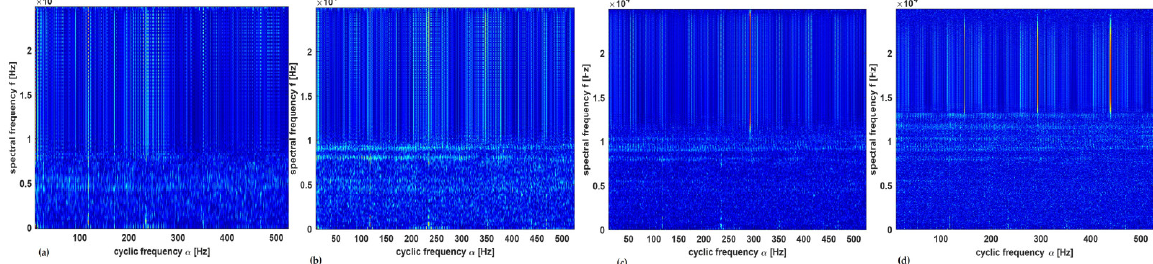
Figure 7. Cyclic spectral coherence maps for healthy shaft at window size: ( a ) 128, ( b ) 256, ( c ) 512, and ( d ) 1024.